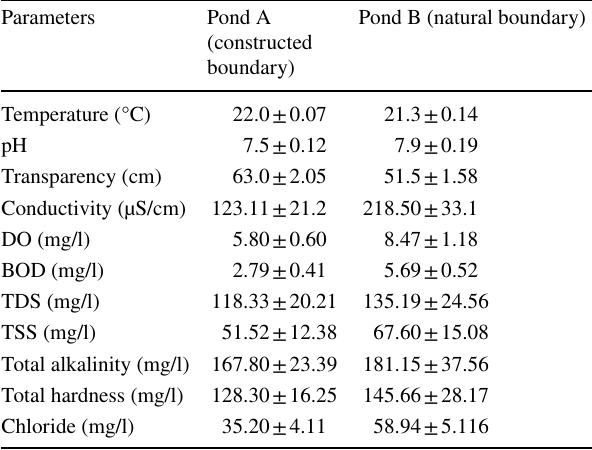
Table 1 Variations in the physicochemical parameters of water sam- ples collected from two urban Ponds (A and B) of Chandannagar dur- ing the study period (Nov–Dec, 2017)